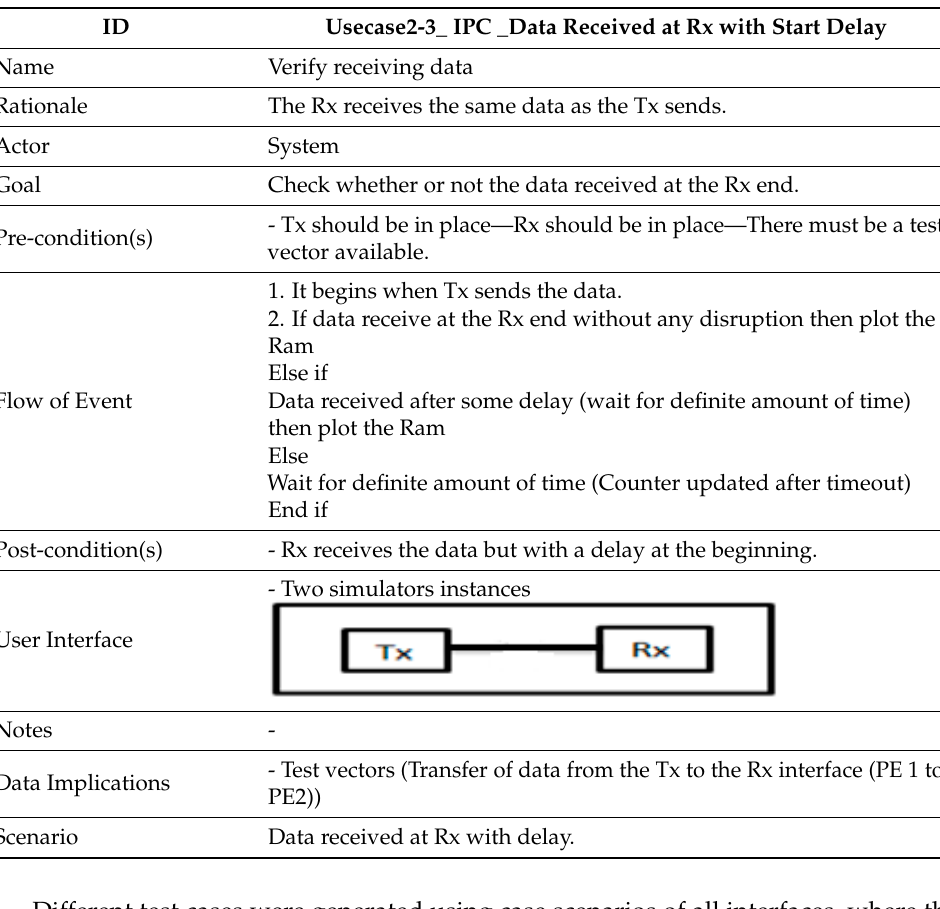
Figure 6. Test case mode. A group of test cases is called a test suite. The test case for “data received at Rx with start delay” is shown in Table 3. While performing the test, the normal flow of events in the proposed framework is represented in Figure 7 as an activity diagram. All the test preconditions must be checked when the trigger event of the corresponding test case takes place. One of the tests related to this particular test case is performed if all the precondi- tions are